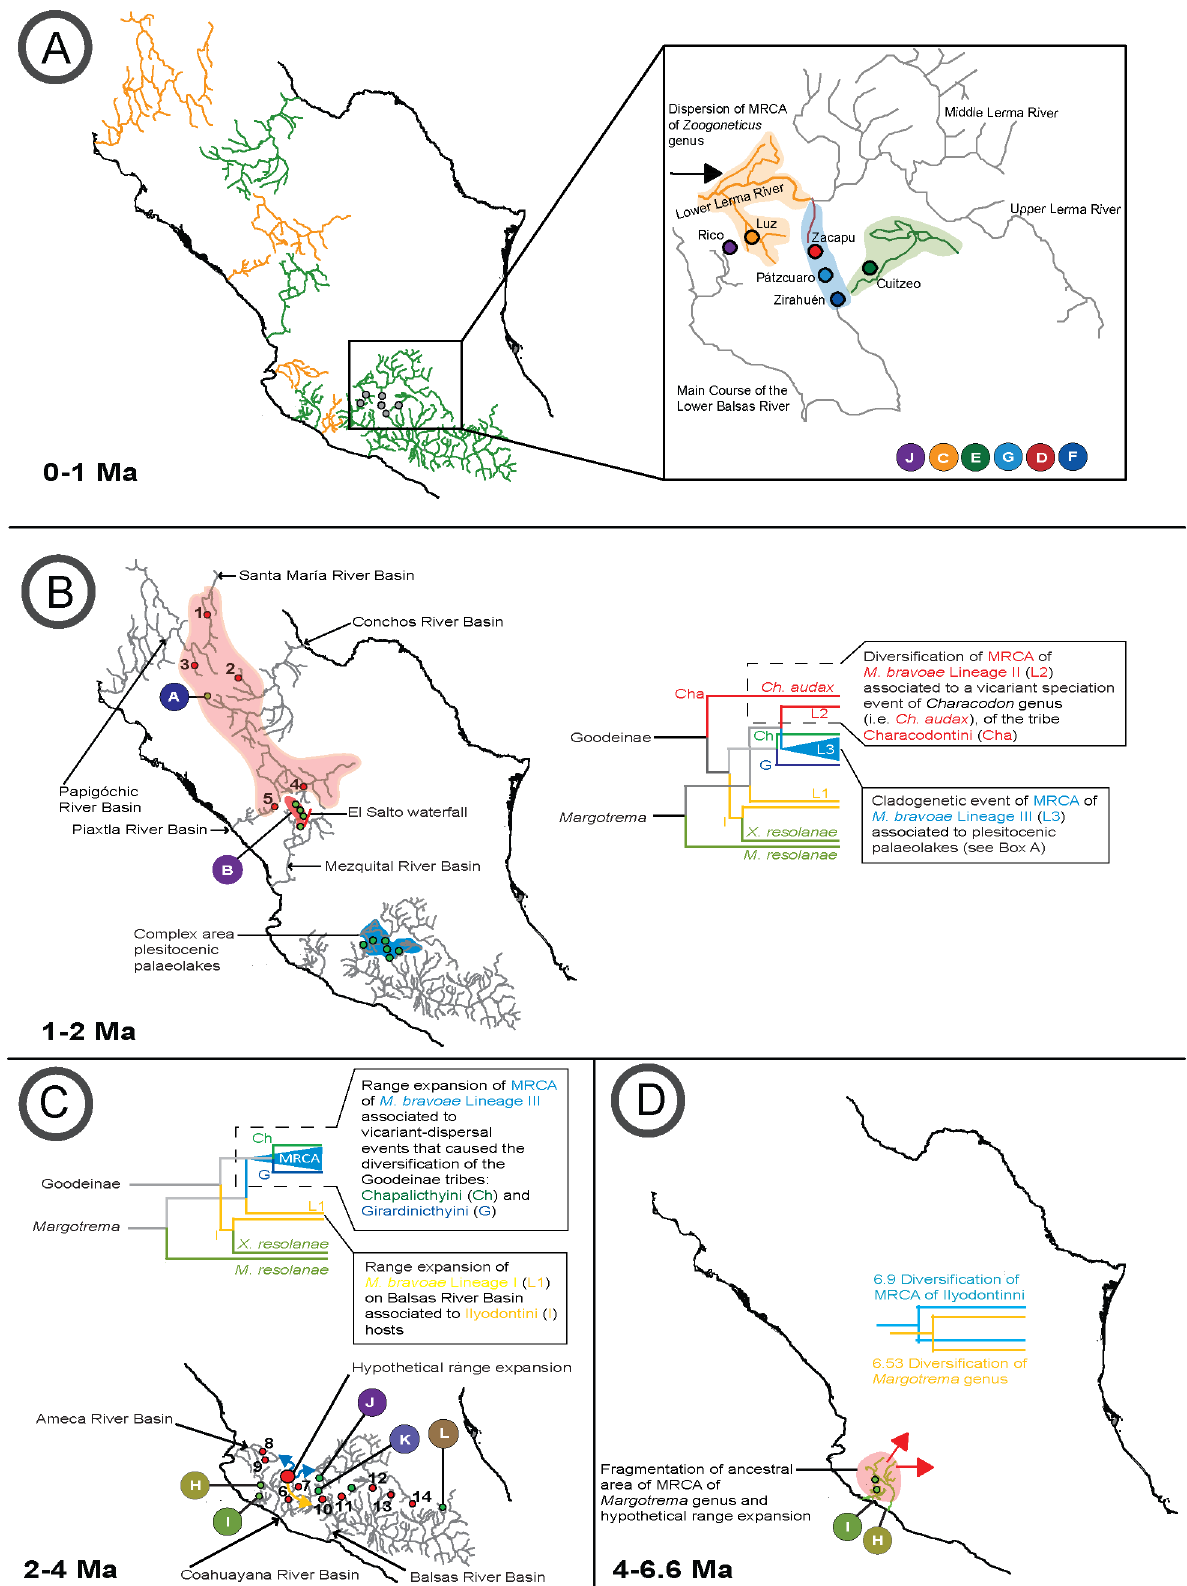
Figure 5. Biogeographic history, codivergence patterns and evolution of Margotrema spp. in central Mexico. Hydrological systems in green and orange in Figure 5A correspond to areas where Margotrema were collected in this study and previous records, respectively. Full green circles with a capital letter correspond to localities analysed in this study; full red circles with a number indicate Margotrema records not collected in PLOS ONE |